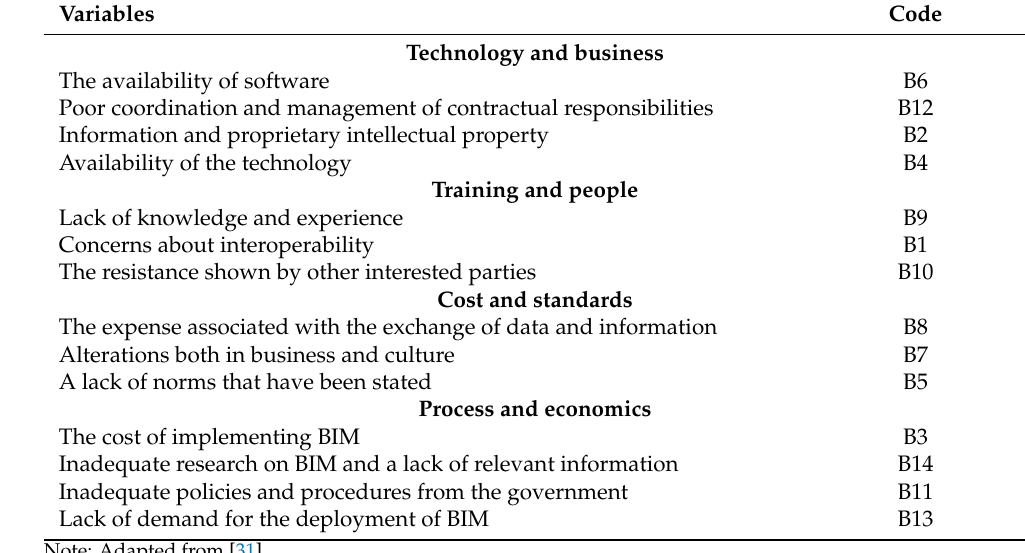
Table 1. BIM adoption